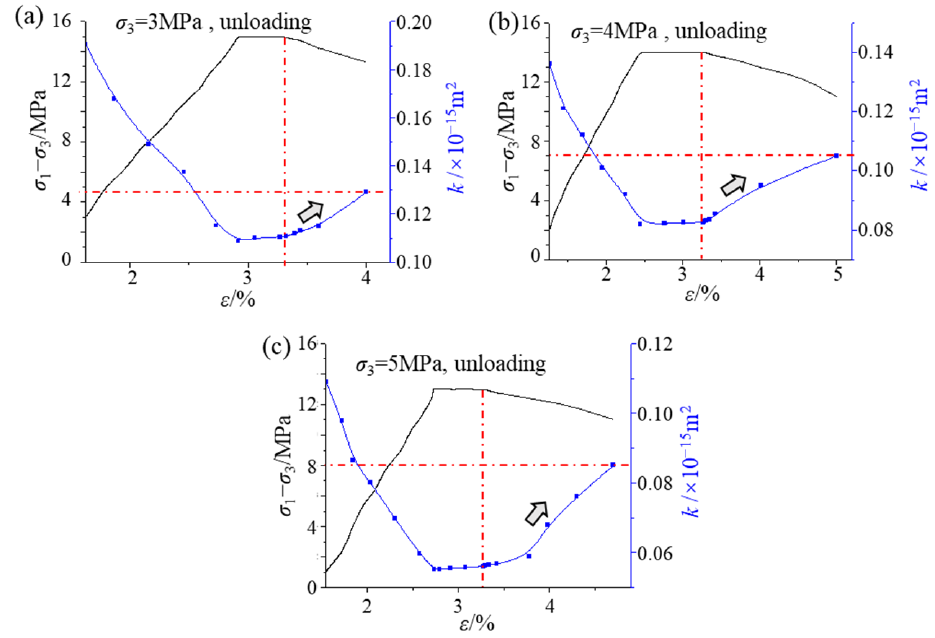
Figure 12. Deviation stress–strain (black line) and permeability curves (blue line) of coal under confining stress releasing